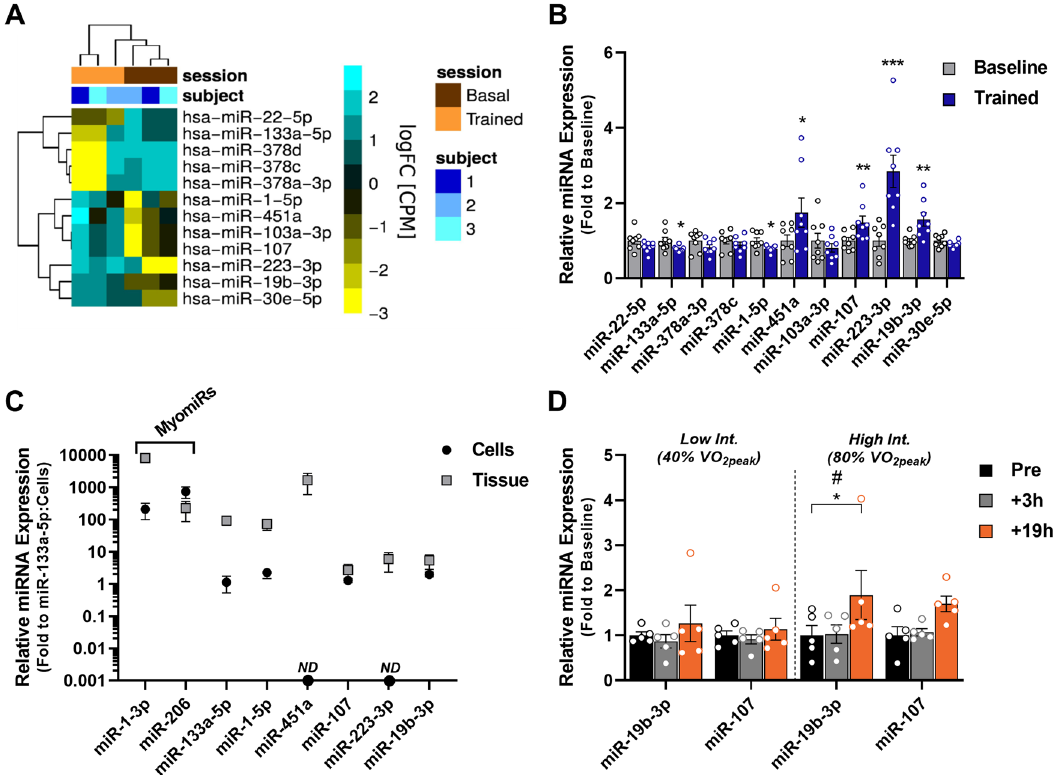
Fig. 1 Aerobic exercise training regulates multiple miRNAs in human skeletal muscle. Skeletal muscle biopsies were obtained from healthy volunteers before and after an aerobic exercise training program. A Altered miRNAs as determined by short RNA sequencing ( n = 3 individuals; FDR < 0.05). B RT- qPCR determination of miRNA expression before (Baseline) and after 14-day aerobic exercise training (Trained) of miRNAs identi fi ed by short RNA sequencing shown in ( A ) ( n = 8 individuals) ( p = 0.024 for miR-133a-5p; p = 0.0236 for miR-1-5p; p = 0.0224 for miR-451a; p = 0.0029 for miR-107; p = 0.0008 for miR-223.3p; p = 0.0013 for miR-19b-3p). C Relative miRNA expression in human skeletal muscle biopsies versus myotubes differentiated in vitro (data are mean ± SD for n = 3 cell culture independent samples and n = 8 tissue independent samples). D miR-19b-3p and miR-107 expression determined by RT-qPCR in human skeletal muscle biopsies obtained at baseline, 3 h, and 19 h after either low intensity (40% VO 2peak ) or high intensity (80% VO 2peak ) aerobic exercise ( p = 0.0228 for miR-19b-3p 19 h following high-intensity exercise; n = 5 individuals). miRNA RT-qPCR data were normalized to miR-186-5p. Data are mean ± SEM. # Exercise effect (Friedman ’ s test); * p < 0.05, ** p < 0.01, *** p < 0.001 using two-tailed paired Student ’ s t - test or Friedman ’ s test followed by Dunn ’ s multiple comparison